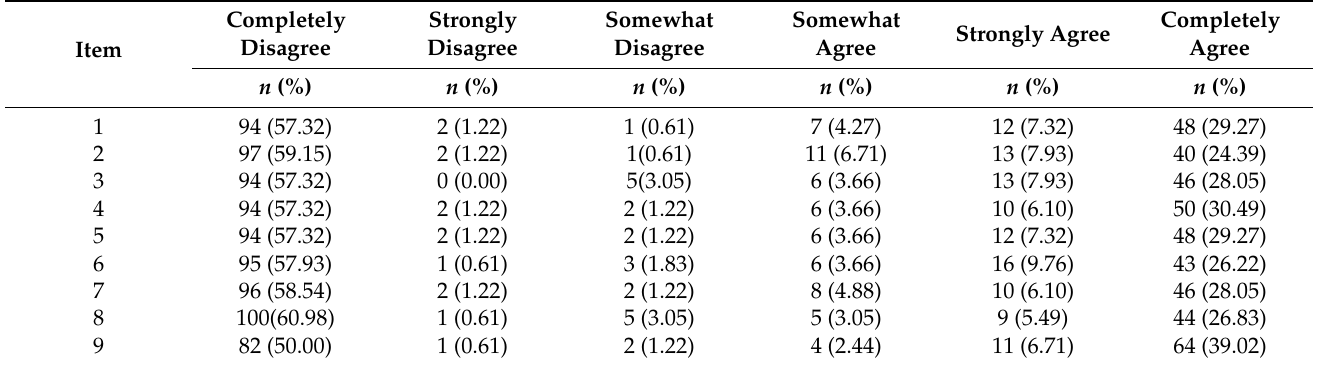
Table A1. Patient distribution for each item based on